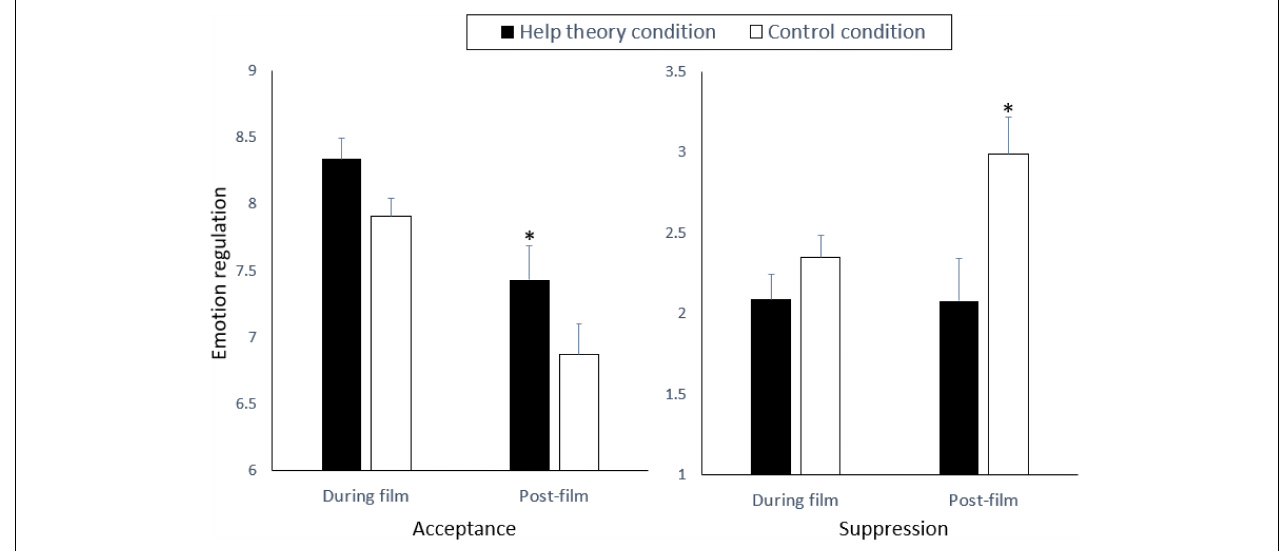
FIGURE 2 | Mean ratings of emotional acceptance and experiential suppression during and after a distressing film by participants in the Help Theory and control conditions in Study 2. Error bars represent ± 1 SE. Asterisks represent statistically significant comparisons ( p < 0.05).